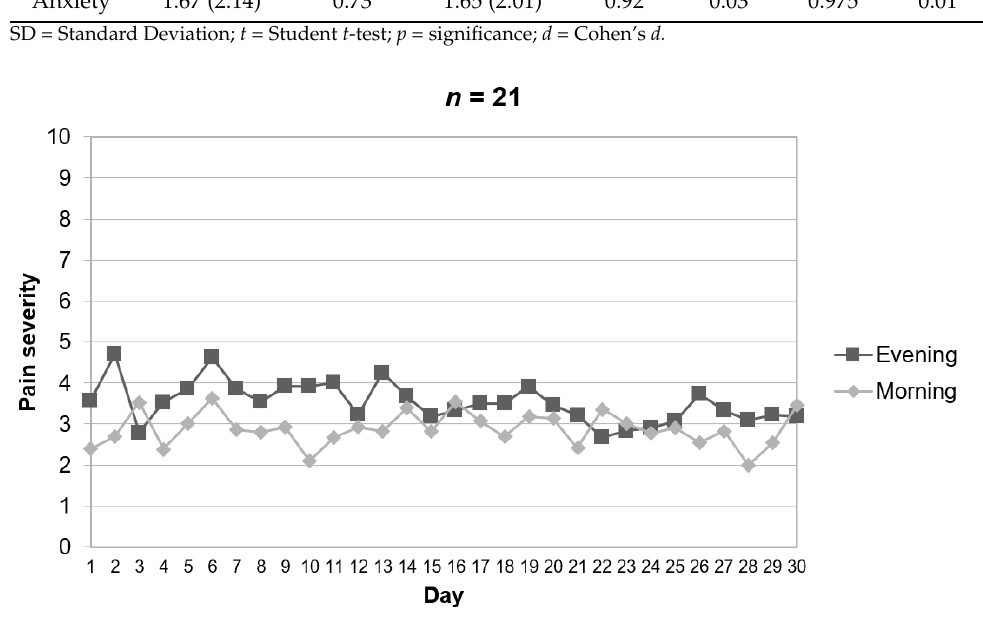
Figure 2. Evolution of baseline pain in the morning and evening during the study based on ecological momentary assessment with the app.